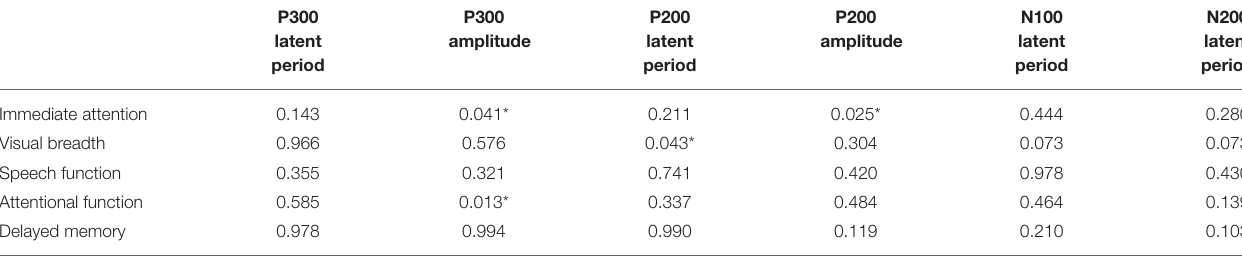
TABLE 7 | Correlation analysis between RBANS scores and ERPs in alcohol-dependence group ( p